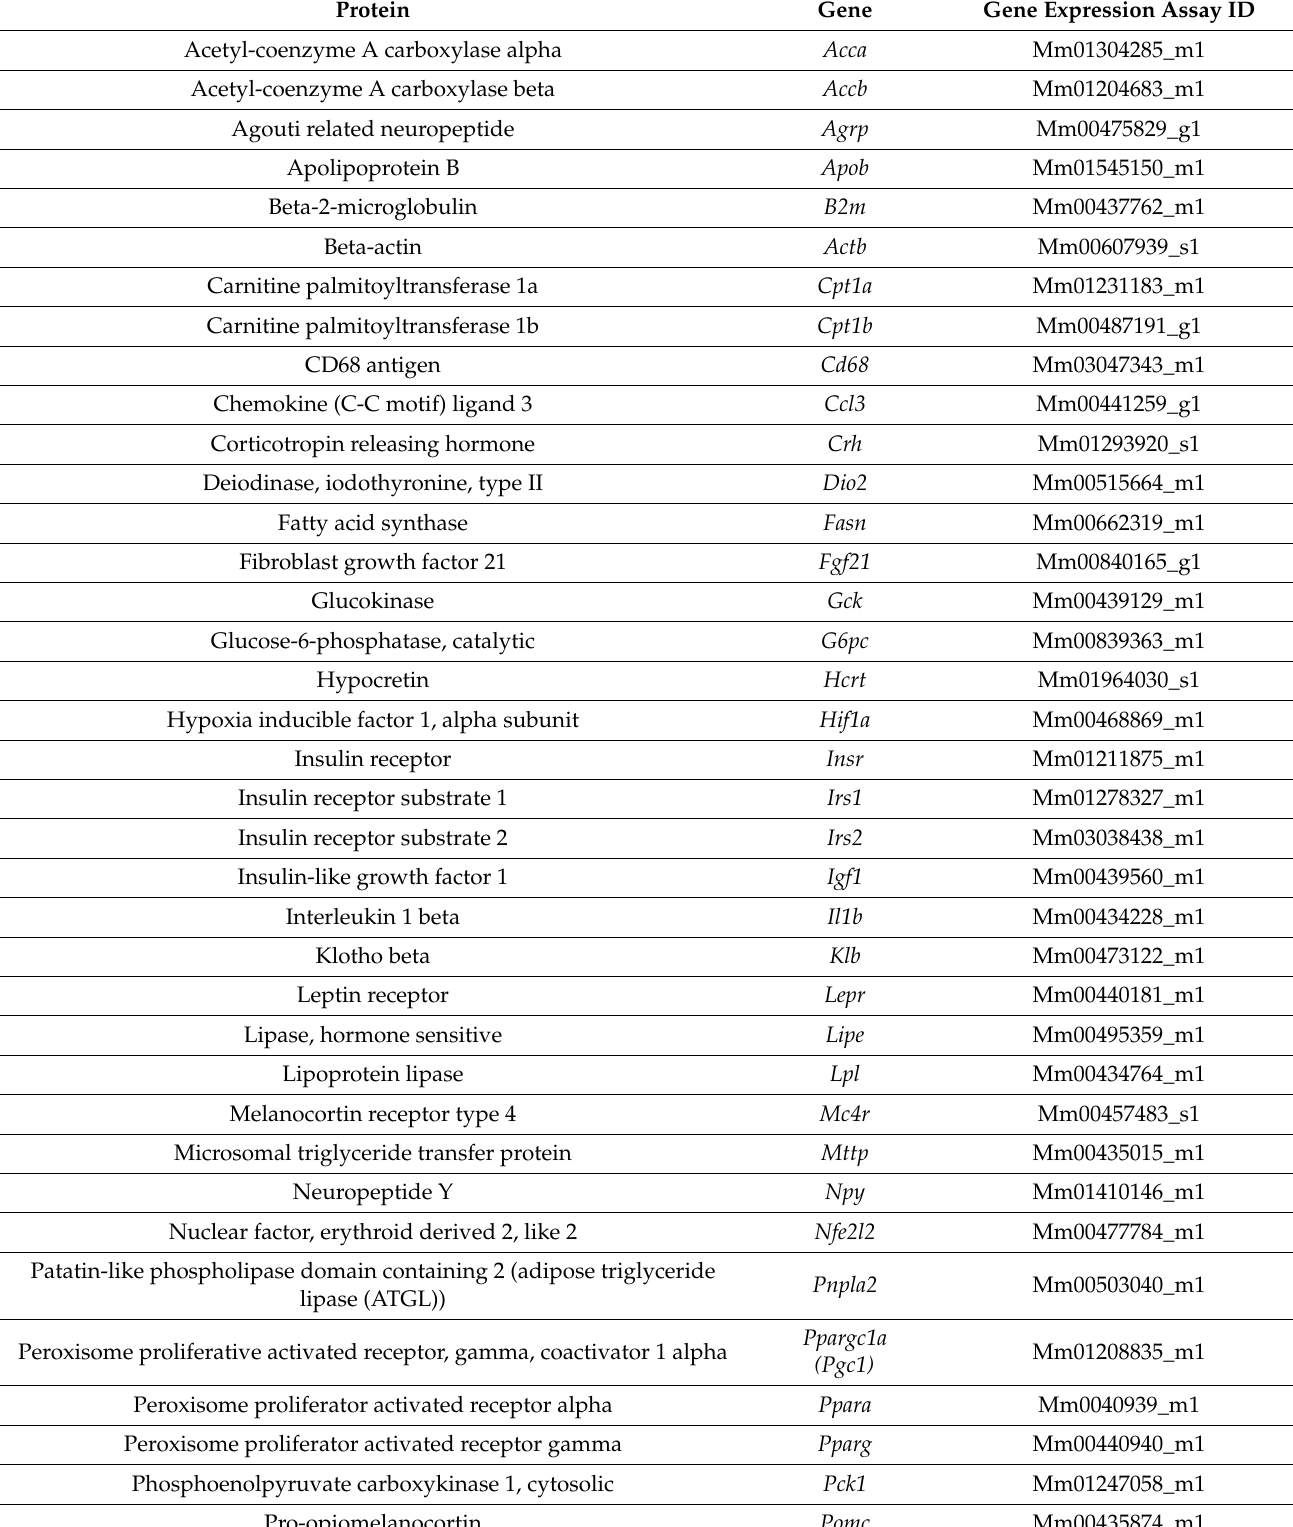
Table 1. TaqMan Gene Expression Assays used for relative quantitation real-time PCR. Protein